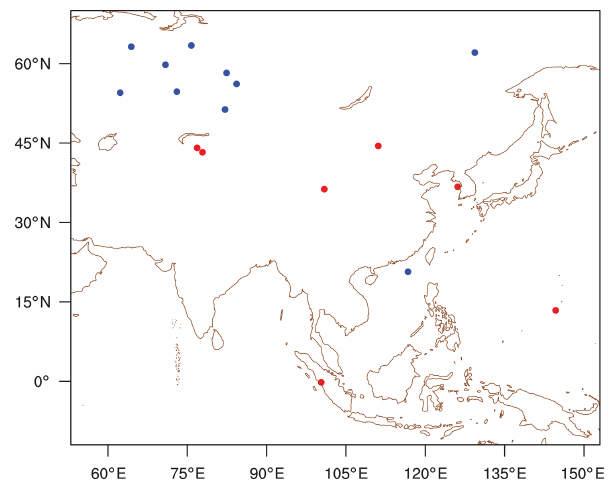
Figure 11. The distribution of observation sites of CNTL_18 in Asia domain: red dots denote 7 observation sites of CT2013B and blue dots denote additional 11 observation sites of CT2017.